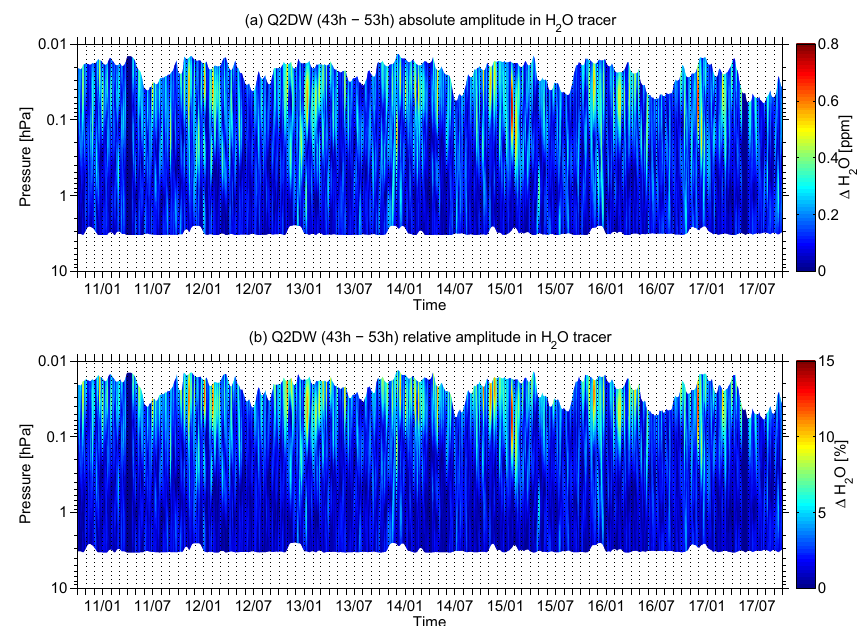
Figure 2. Evolution of absolute (a) and relative (b) Q2DW amplitude in water vapor data from the middle atmospheric water vapor radiometer MIAWARA in the time period from 1 October 2010 to 30 September 2017. The data product is shown in the altitude region where it can be regarded as reliable according to Fig.